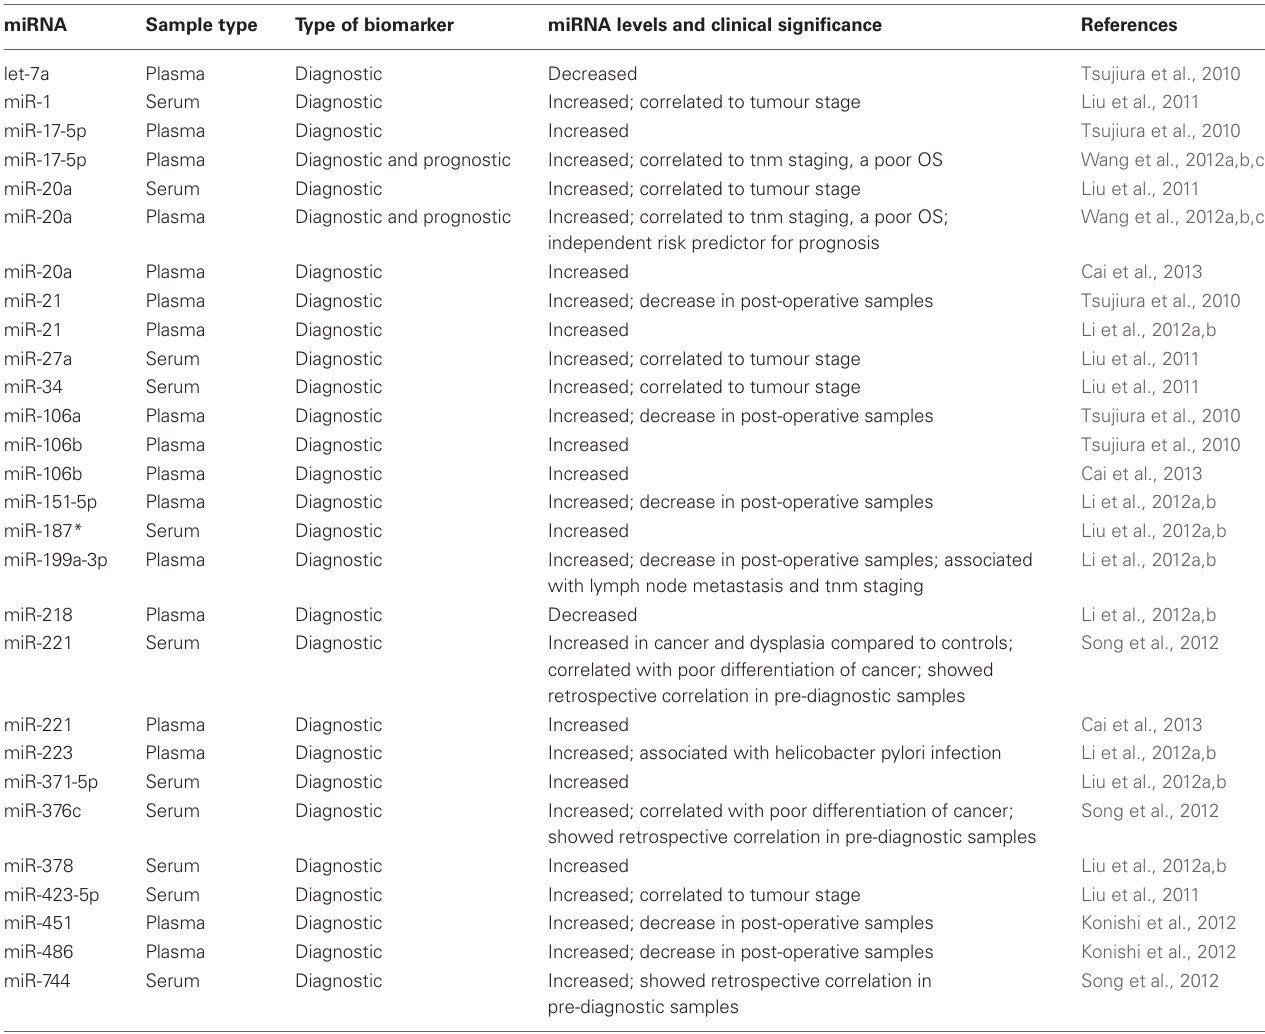
Table 5 | Circulating miRNAs reprted to be a biomarker for gastric cancer.